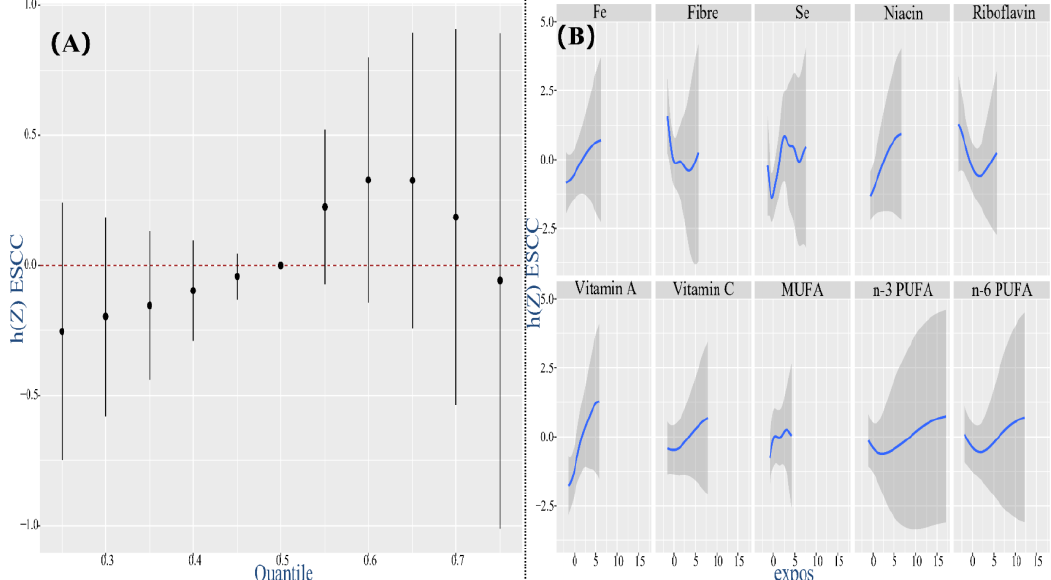
Figure 5. Associations between 10 anti−inflammatory nutrients (predictors) and ESCC (outcome) by BKMR model adjusting for age, gender, education, income, occupation, tobacco smoking, drinking intensity, tea consumption, eating speed per meal and hot food. ( A ) The estimated overall effect of 13 dietary nutrients as compared to when all of the other nutrients are at the 50th percentile. The red dotted line means the reference level at which all of nutrients are fixed to their 50th percentile, to achieve interests of computing the overall effect of the mixture. ( B ) The univariate exposure– response function of each nutrient when setting the remaining nutrients at their median level. Ab-